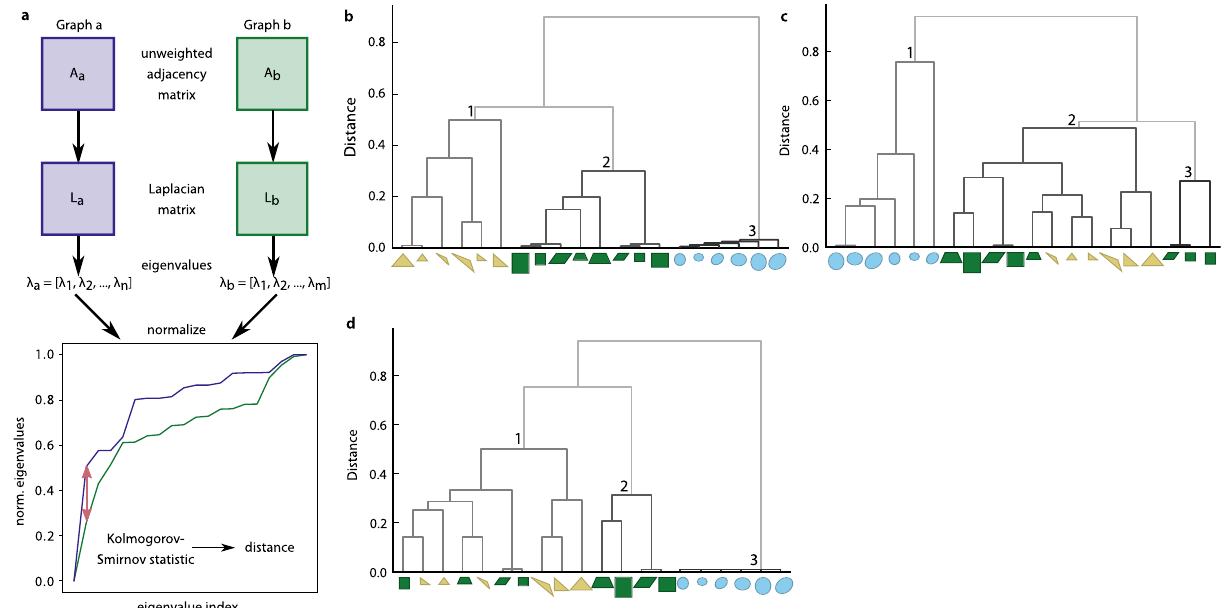
Fig. 2 Comparison of unweighted visibility graphs. a Two visibility graphs are compared based on the spectrum (i.e., distribution of eigenvalues) λ of the Laplacian L obtained from the unweighted adjacency matrices A . The Kolmogorov – Smirnov statistic is used to quantify the difference between the distributions of two spectra. b – d Clustering dendrogram obtained by the procedure for a set of synthetic, simple triangular, circular, and rectangular shapes with b the same number of nodes, c variable number of nodes between the network representations of the shapes, and d variable number of nodes which were reduced using modularity clustering to have the same number of nodes. Source data are provided as a Source Data fi le.